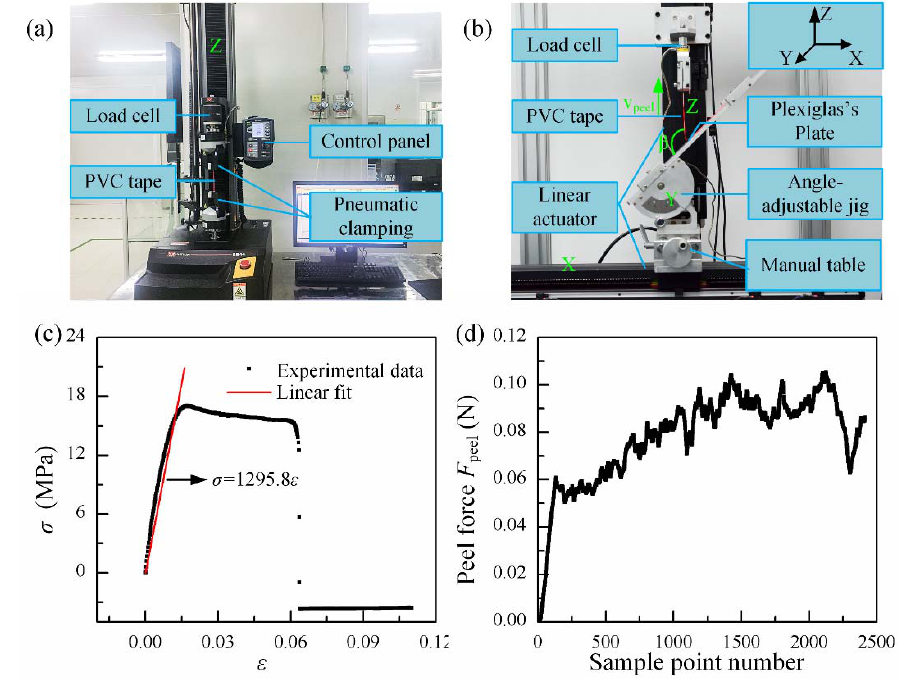
Figure A4. Experimental apparatus and experimental data for material parameter test: ( a ) an universal mechanical tester (INSTRON 5944); ( b ) a home-made peel platform with an angle-adjustable jig, in which the X or Z-motion of the translation stage is able to be driven by two independent linear/electric actuators, and its Y-motion depends on a manually single axis table; ( c ) stress-strain curve for PVC sticker in tension test; and ( d ) peel force for PVC sticker in peel test with peel angle β = 135 ◦ and peel rate v peel = 1 1mm s .